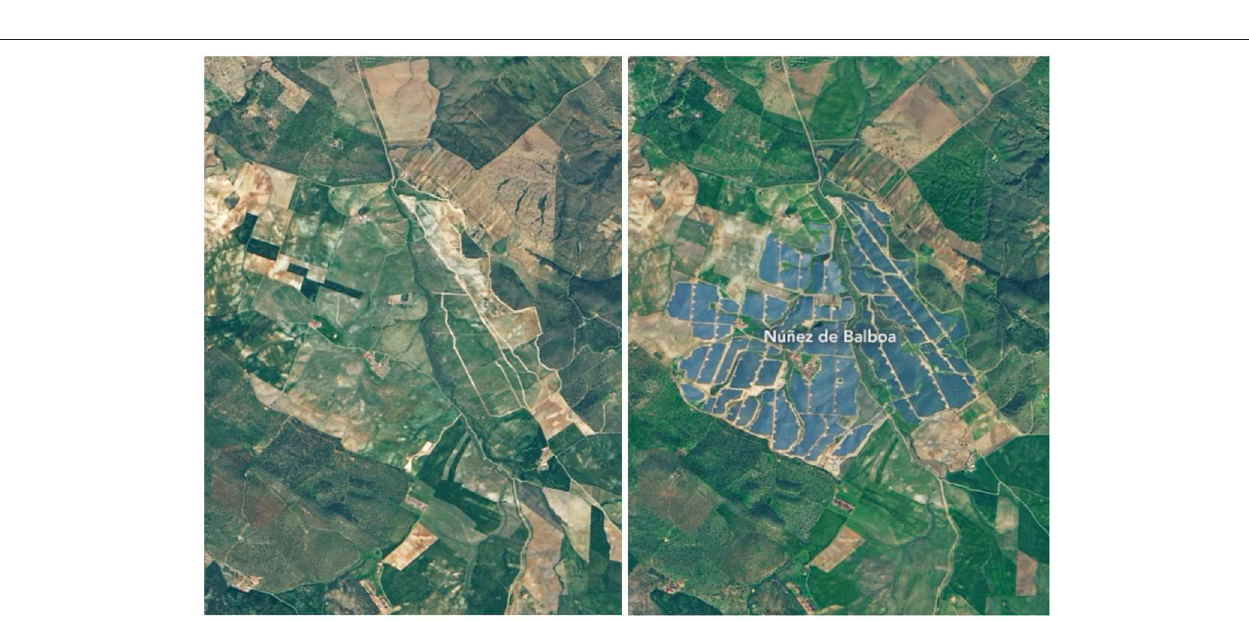
FIGURE 3 | Satellite images of a 500 MW solar power plant on the Iberian Peninsula. (L) shows imaging before installation in 2020, (R) shows imaging after installation (Credit: NASA Earth Observatory image by Lauren Dauphin, using Landsat data from the U.S. Geological Survey).